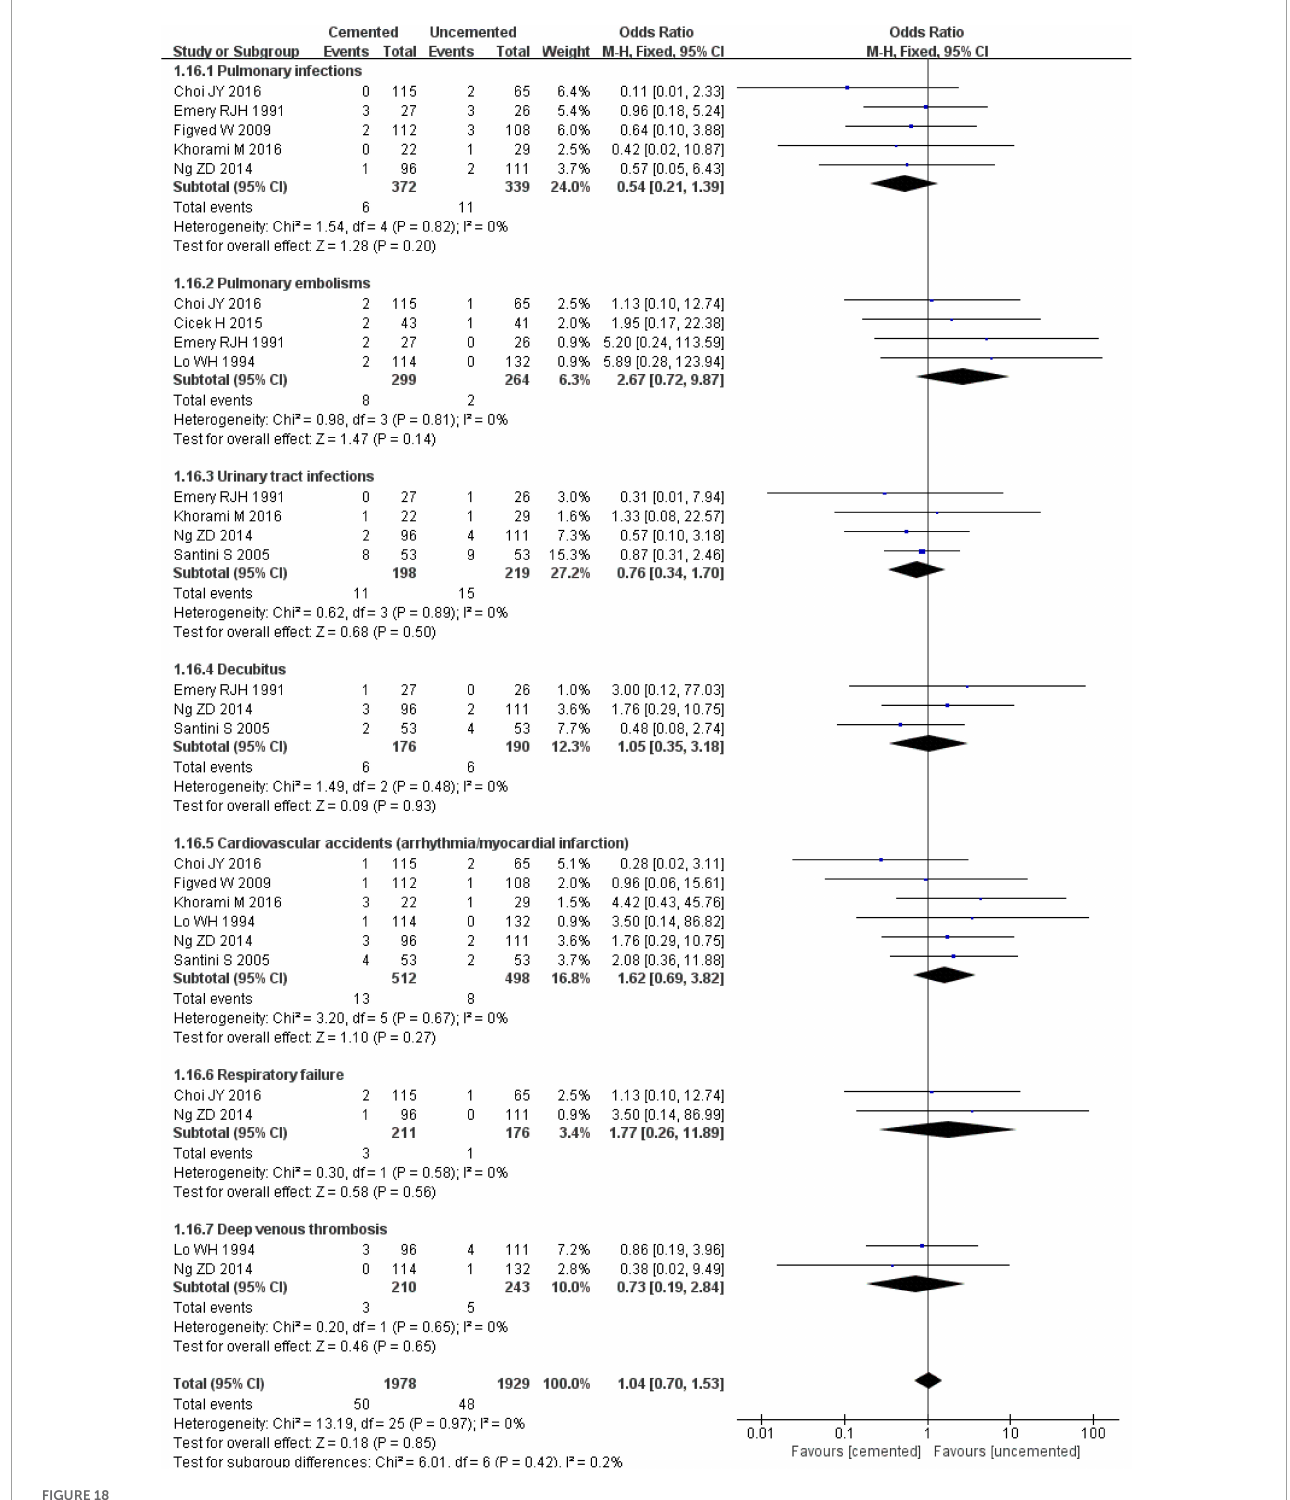
FIGURE18 Forest plot for comparison of general complications between cemented bipolar hemiarthroplasty (CBH) group and uncemented bipolar hemiarthroplasty (UCBH) group.